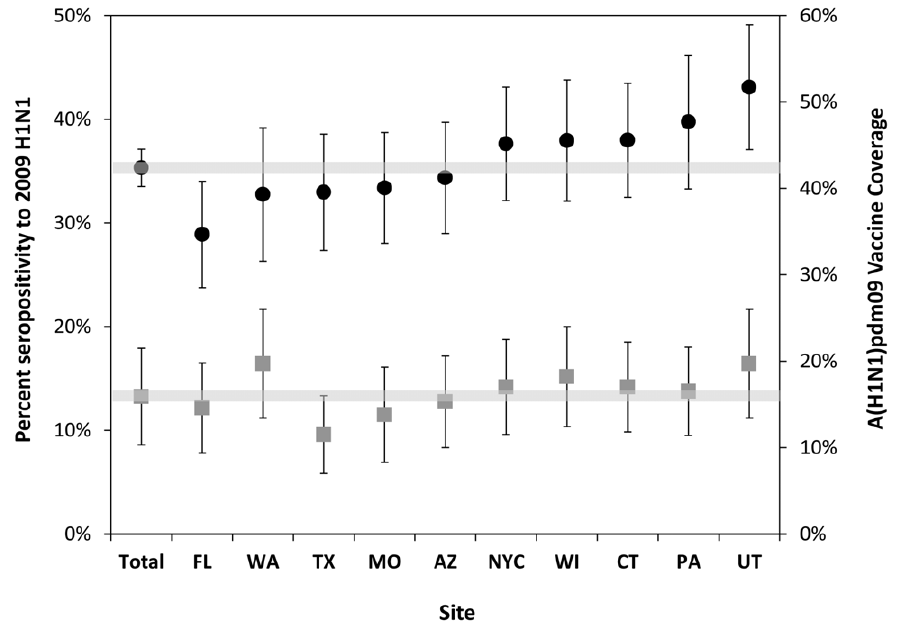
Figure 3. Geographic variation in prevalence of seropositivity to A(H1N1)pdm09 in 2009 (circles) and the proportion of the population reporting A(H1N1)pdm09 vaccination (squares) during the same time period, by state with 95% confidence intervals. Values are age–standardized to the US population.